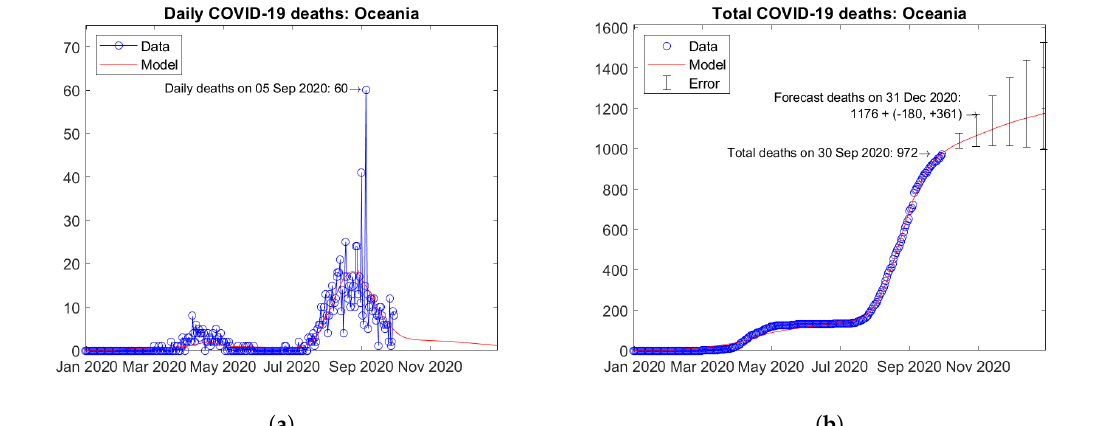
Figure 32. Actual and predicted trends in Guam: ( a ) daily deaths, ( b ) total deaths.